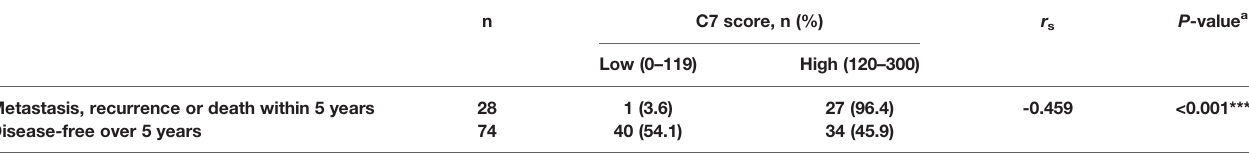
TABLE 5 | Relationship between C7 expression and prognosis of IDC patients treated with TE